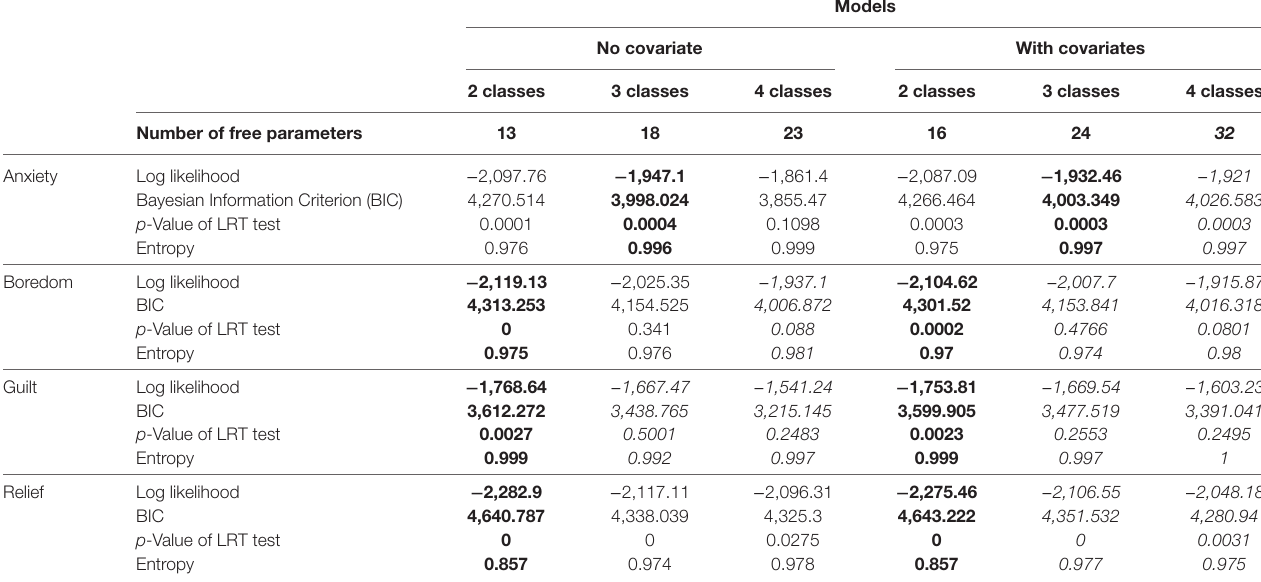
Table 4 | Latent profile analysis